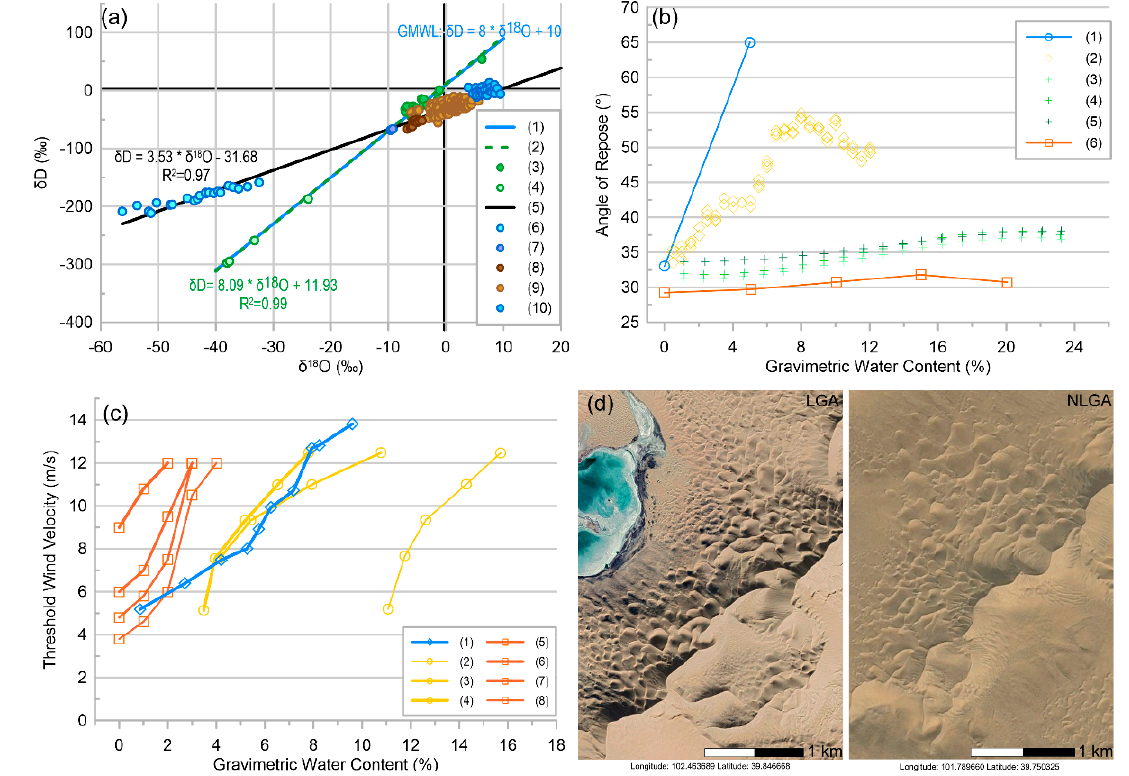
Figure 9. ( a ) Isotope δ D- δ 18 O composition of the Global Meteoric Water Line (GMWL) (1), local meteoric water line (rainfall and snow water) (2), rainfall (3), snow water (4), evaporation line (5), atmospheric water vapor (6), condensate water (7), groundwater (8), soil water (9), and lake water (10) in the lake group area of the Badain Jaran Sand Sea [32]. ( b ) Variation of the angle of repose with water content in non-uniform sand [59,60] and uniform sand with different grain sizes [61,62]. (1) Non-uniform sand [59]. (2) Non-uniform sand [63]. (3) Very fine sand [61]. (4) Fine sand [61]. (5) Coarse sand [61]. (6) Fine sand [62]. ( c ) Variation of threshold wind velocity with water content in different types of soil and in sand with different grain sizes [64–66]. (1) Sandy loam [65]. (2) Clay [64]. (3) Loam [64]. (4) Fine sandy loam [64]. (5) 1.0–2.0 mm [66]. (6) 0.5–1.0 mm [66]. (7) 0.25–0.5 mm [66]. (8) 0.175–0.25 mm [66]. ( d ) Morphological comparison of superimposed dunes on windward slope of dunes in lake group area (LGA) and non-lake group area